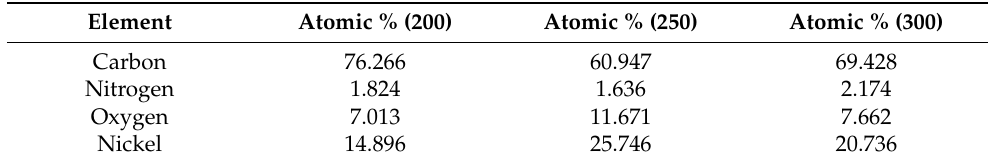
Table 1. Elemental contents of CNFs@Ni(OH) 2 /NiO-X.